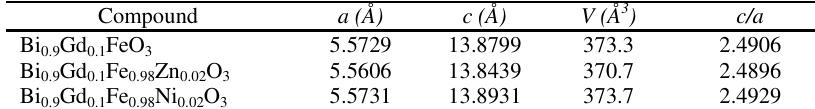
Table 2. Some structural parameters of the Gd-doped BiFeO